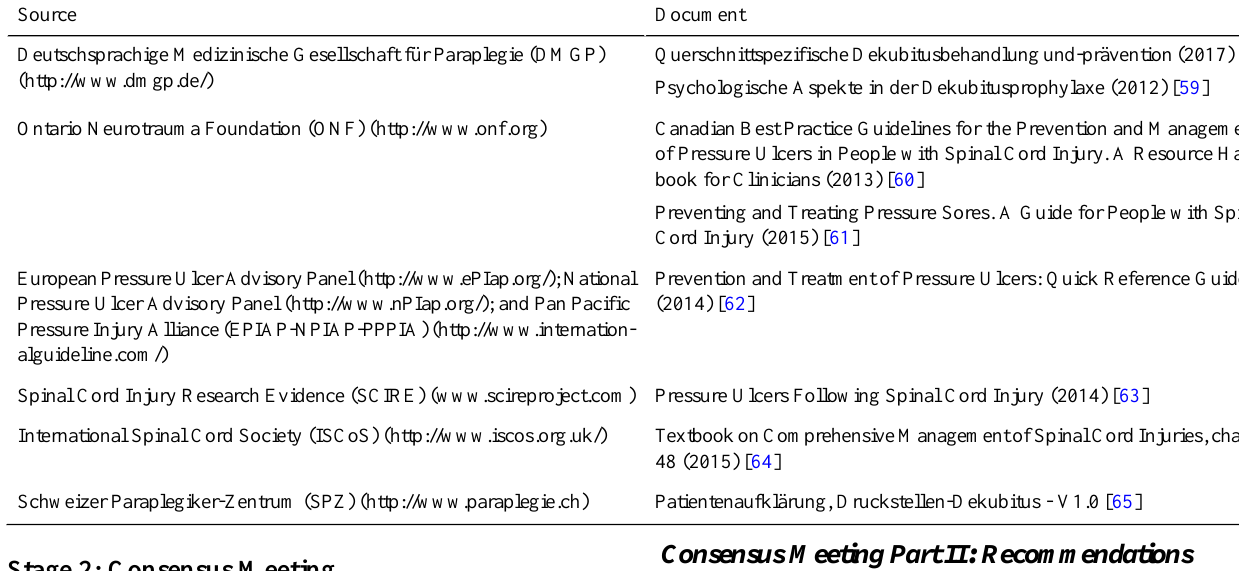
Table 2. Documents reviewed for the identification of recommendations.